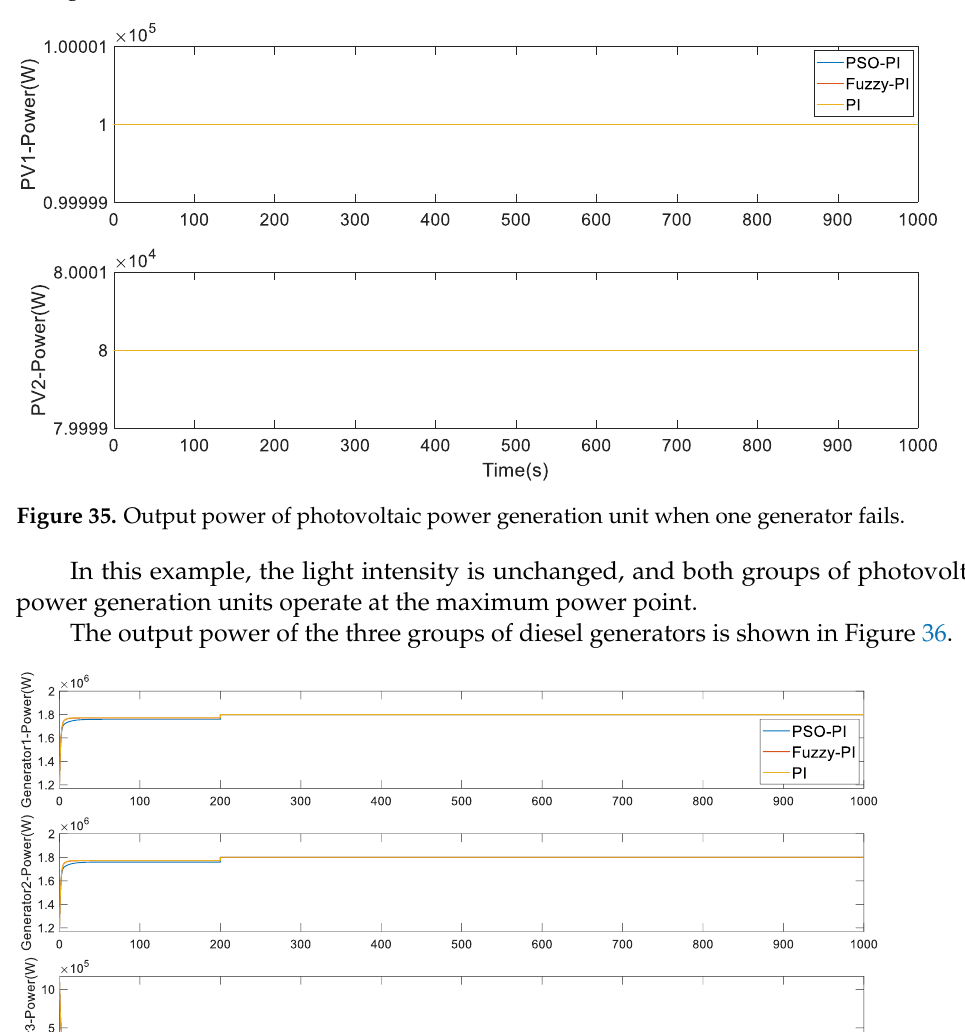
Figure 34. DC bus voltage when one generator fails without AA-CAES .